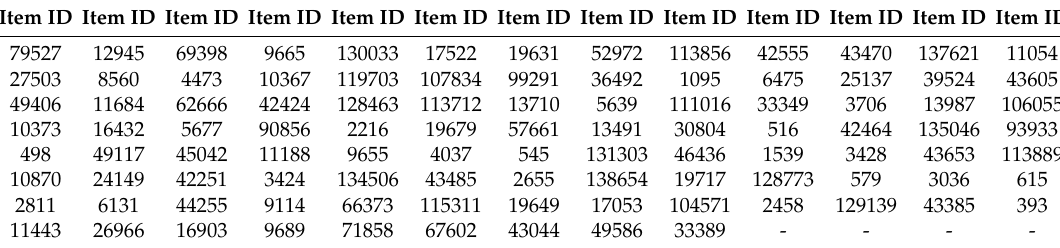
Table 4. 100 random target item IDs, respectively, from 100 group